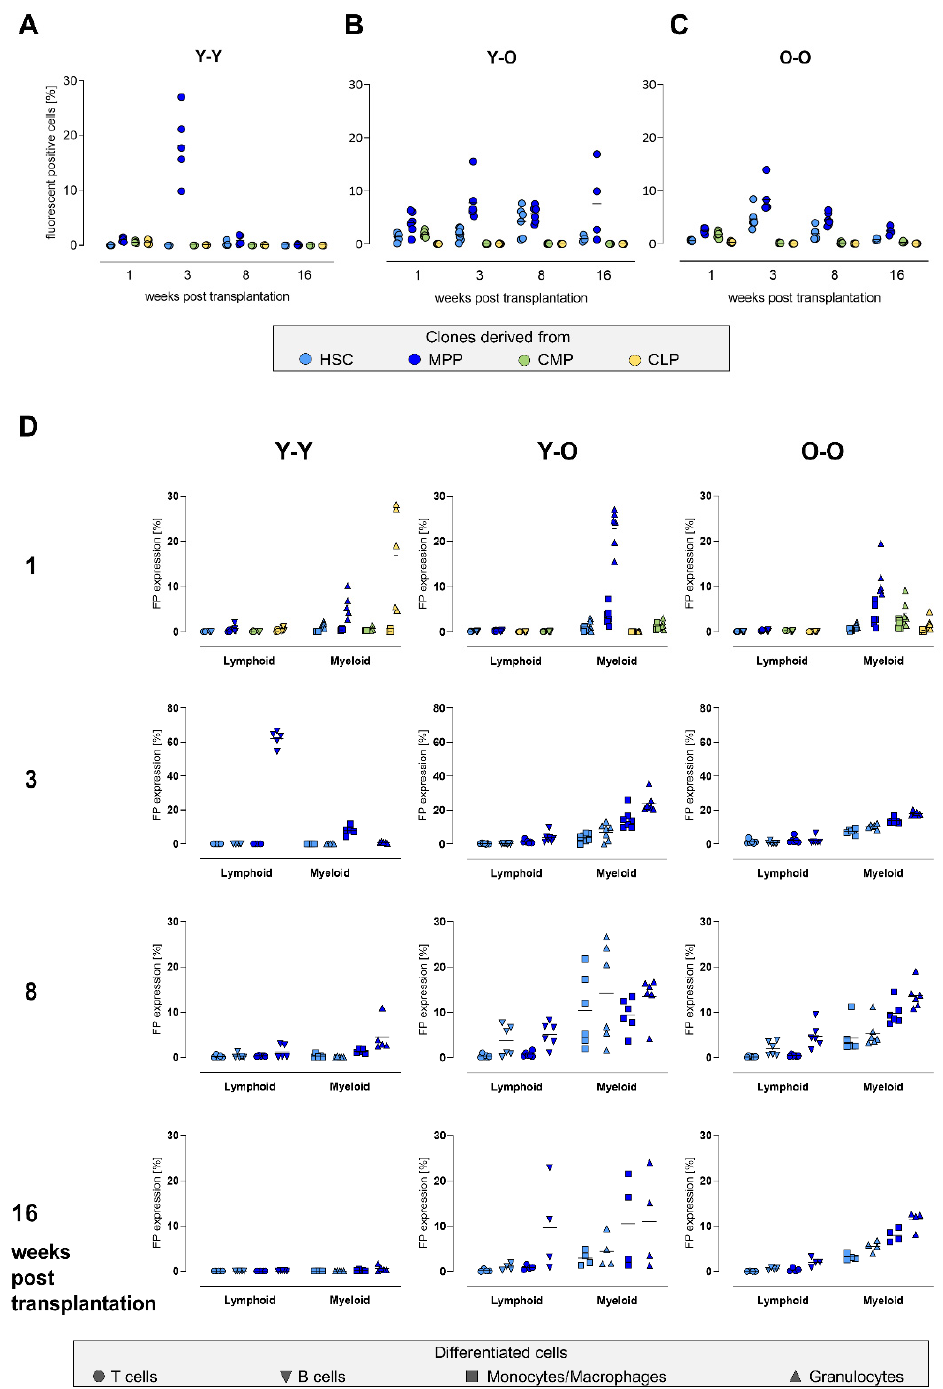
Figure 3. Contribution of the transduced cell populations. ( A – C ) Single-cell suspensions from the spleen were used to determine the overall contribution of the initially marked cell populations via their fluorescent protein expression by flow cytometry. ( D ) FP expression was also measured in the lymphoid (T cell (CD3) and B cells (B220)) and myeloid (monocytes/macrophages (CD11b) and granulocytes (CD11b/Ly6G)) compartments to analyze their contribution in more detail. The spleen mostly comprised HSC- and MPP-derived cells. CMP-derived cells were solely detectable 1 week after transplantation. CLP-derived cells were barely detectable. No data were available for CMP- and CLP-derived cells 3, 8, or 16 weeks post transplantation. Light-blue dots: HSC-derived clones, dark-blue dots: MPP-derived clones, green dots: CMP-derived clones, and yellow dots: CLP-derived clones.